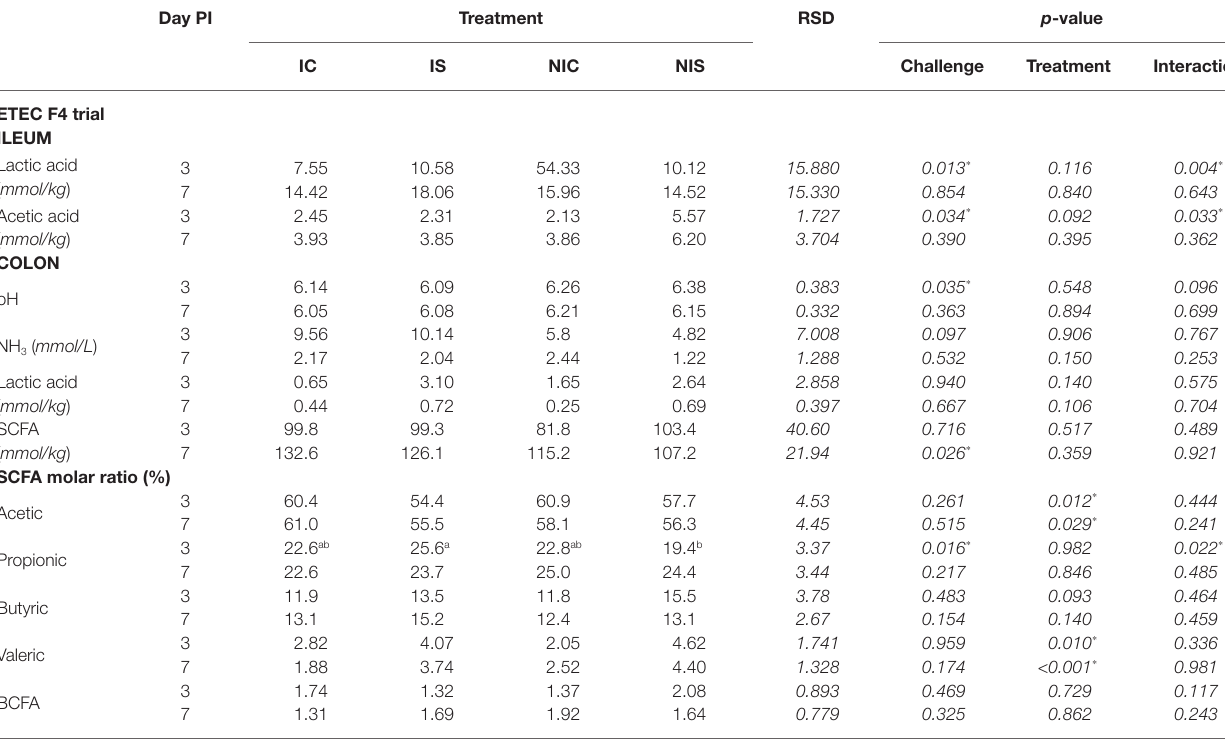
TABLE 5 | Effects of experimental treatments on ileal and colonic fermentation in ETEC F4 trial. Day PI